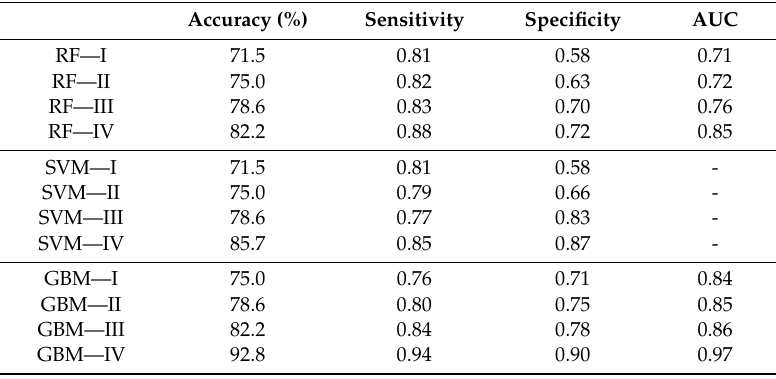
Table 4. Summary of model